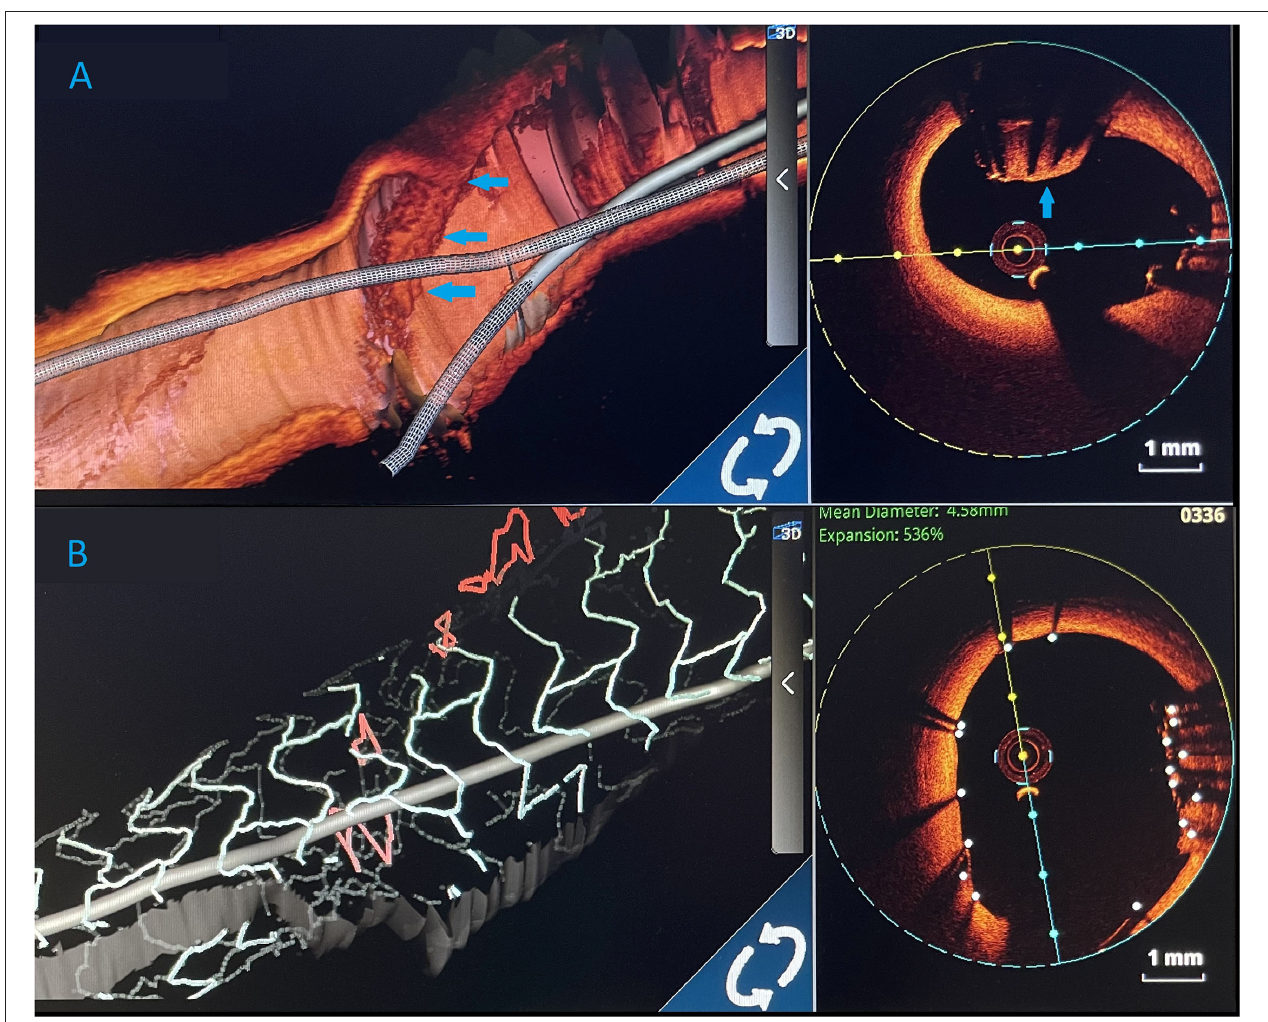
FIGURE 4 | Three-dimensional (3D) images. (A) 3D render of an optical coherence tomography (OCT) showing an undeployed lost stent (blue arrows) in the left main artery. (B) Optical coherence tomography 3D view. After LM stent implantation, lost stent (blue arrows) is successfully crushed against the left main artery